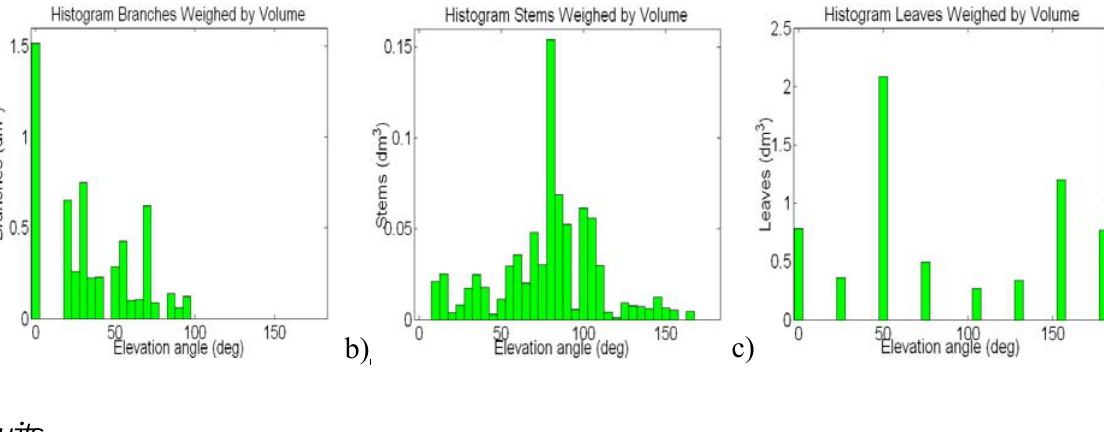
Figure 6. Histogram of the elevation angle of the vegetation elements weighted by the volume occupied a) Branches, b) stems, and c)